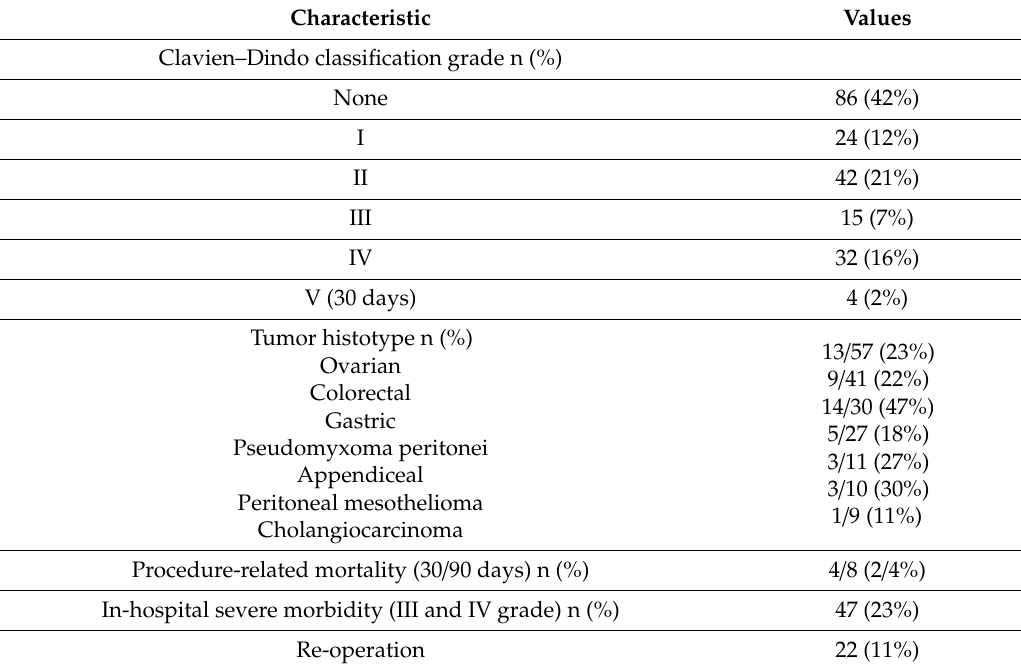
Table 4. Postoperative complications for CRS + HIPEC according to Clavien–Dindo